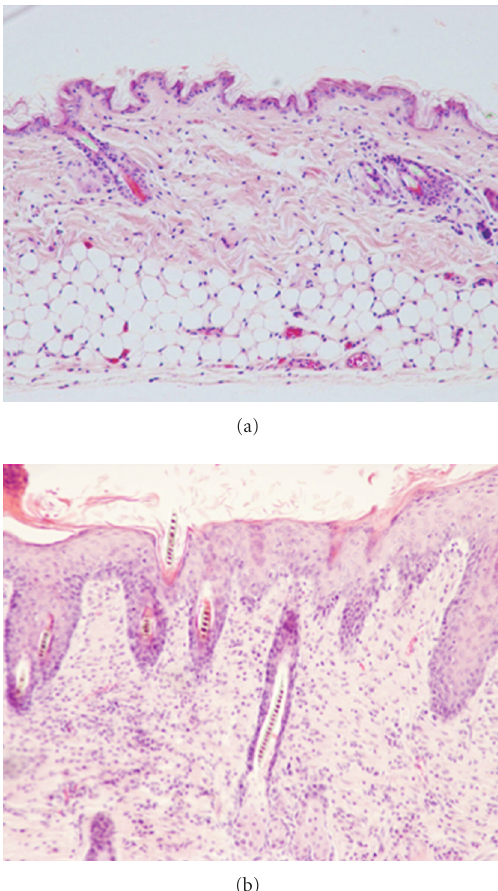
Figure 2: Generation of mast cell-deficient NC/NgaTnd mice. NC/NgaTnd mice with heterozygous (a) and homozygous (b) for the mast cell-deficient Wsh gene